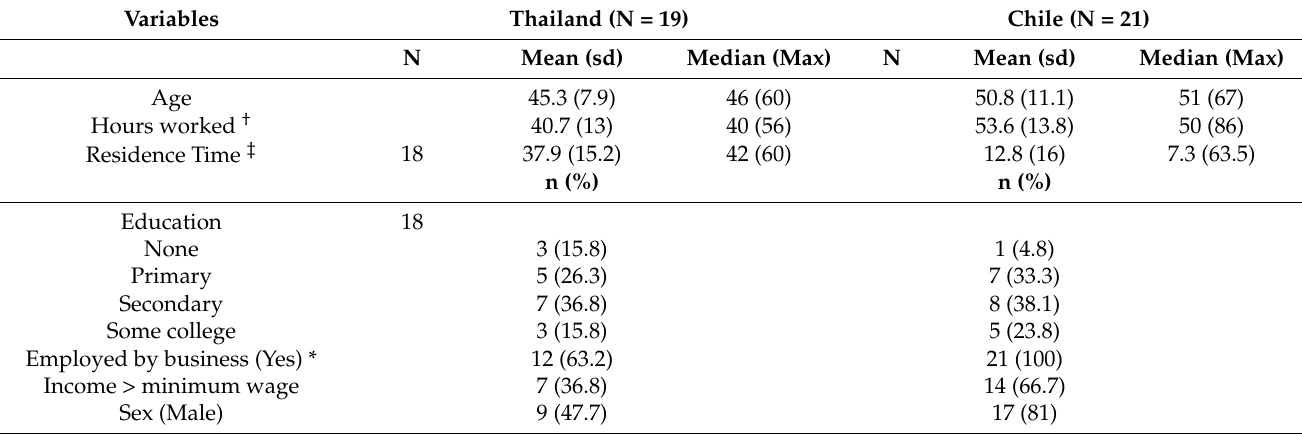
Table 3. Demographics among Thai and Chilean e-waste recycling workers with video recordings.